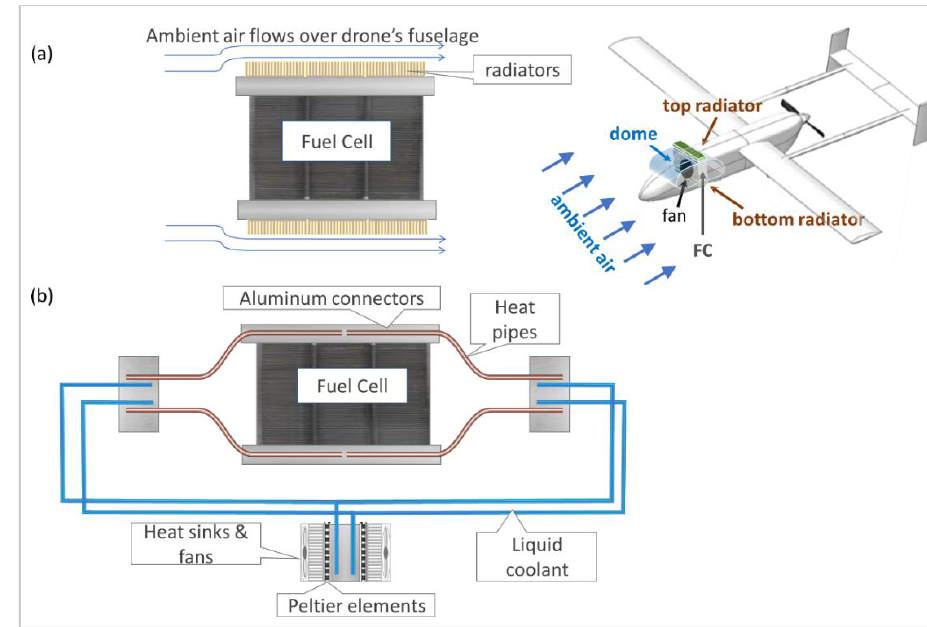
Figure 6. The designed FC edge cooling for UAV, based on convection by ambient air ( a ) as was simulated in the experiments using heat pipes and liquid cooling ( b ). The coolant liquid is cooled down by Peltier elements with an attached heat sink and fans.